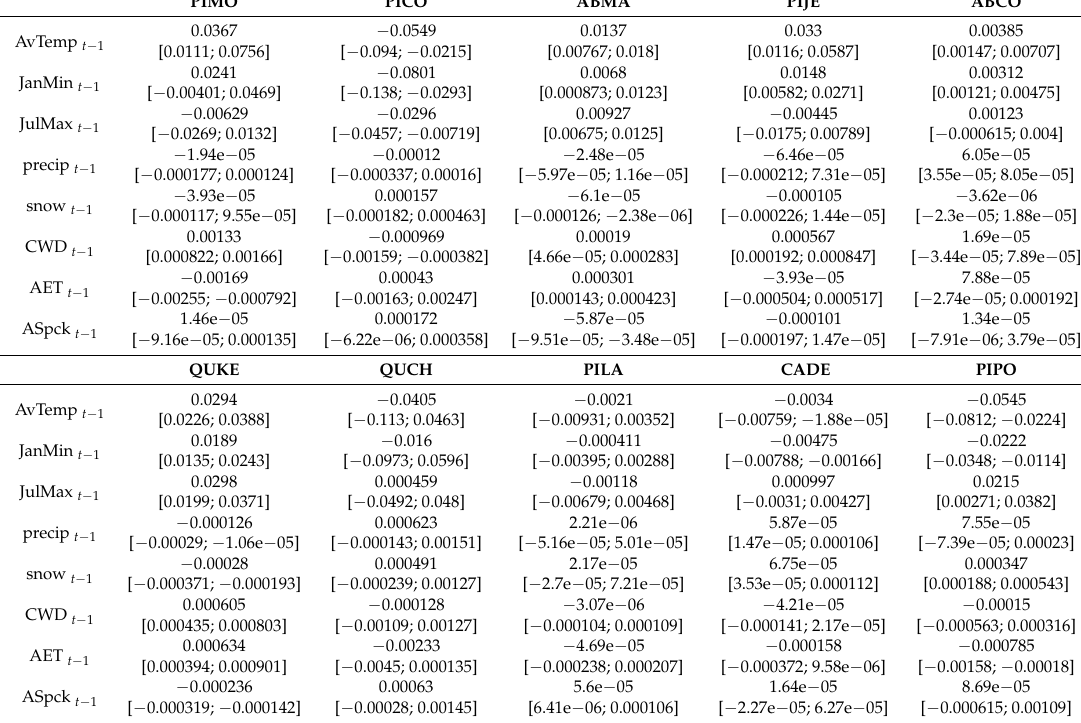
Table A4. Climate parameter estimated by a different model for each climate variable from the previous water year (model used for the selection). 95% CI in